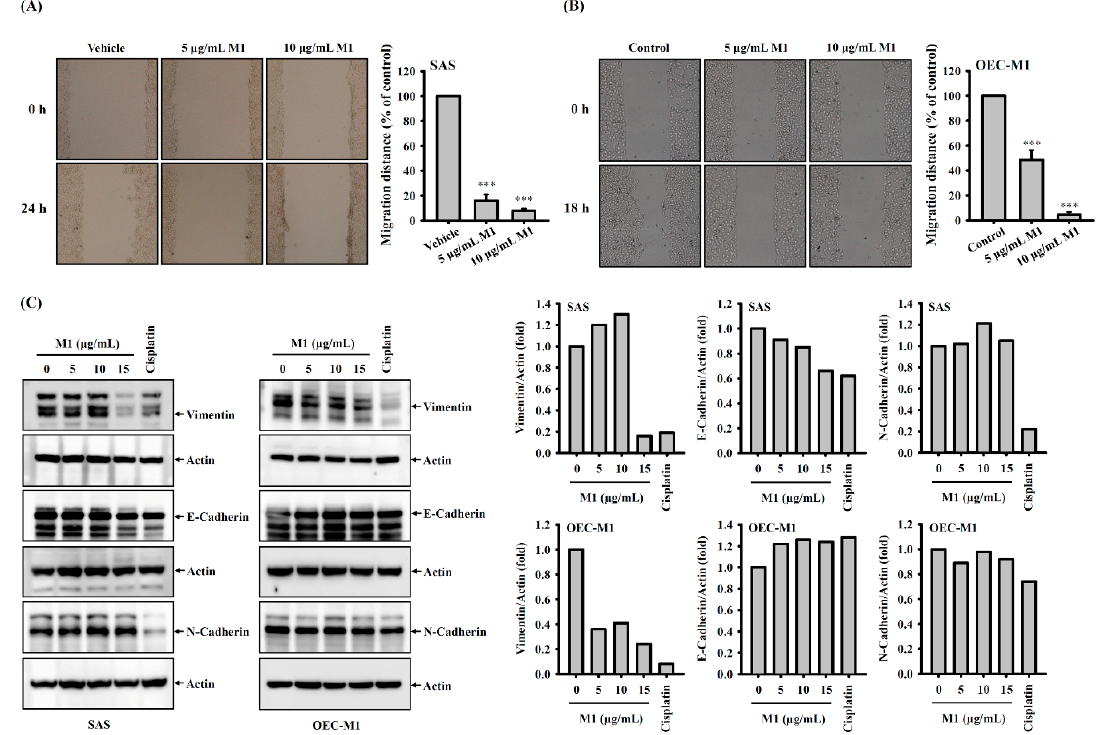
Figure 7. Ginsenoside M1 reduced the migration ability of human oral cancer cells. SAS cells ( A ) or OEC-M1 cells ( B ) were incubated with ginsenoside M1 or vehicle for 24 or 18 h, respectively. The cell migration ability was measured by wound healing assay. ( C ) SAS cells and OEC-M1 cells were incubated for 24 h with ginsenoside M1, 50 µM cisplatin, or vehicle. The expression levels of vimentin, E-cadherin, and N-cadherin were analyzed by Western blotting. The data were expressed as mean ± SD; n = 3. *** indicates a significant difference at the level of p < 0.001, compared to vehicle-control cells. (One-way ANOVA with Dunnett’s multiple comparisons test).